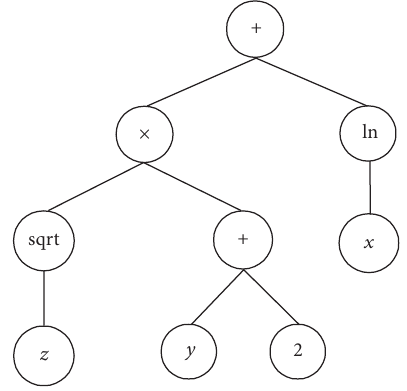
Figure 3: Form of genetic programming